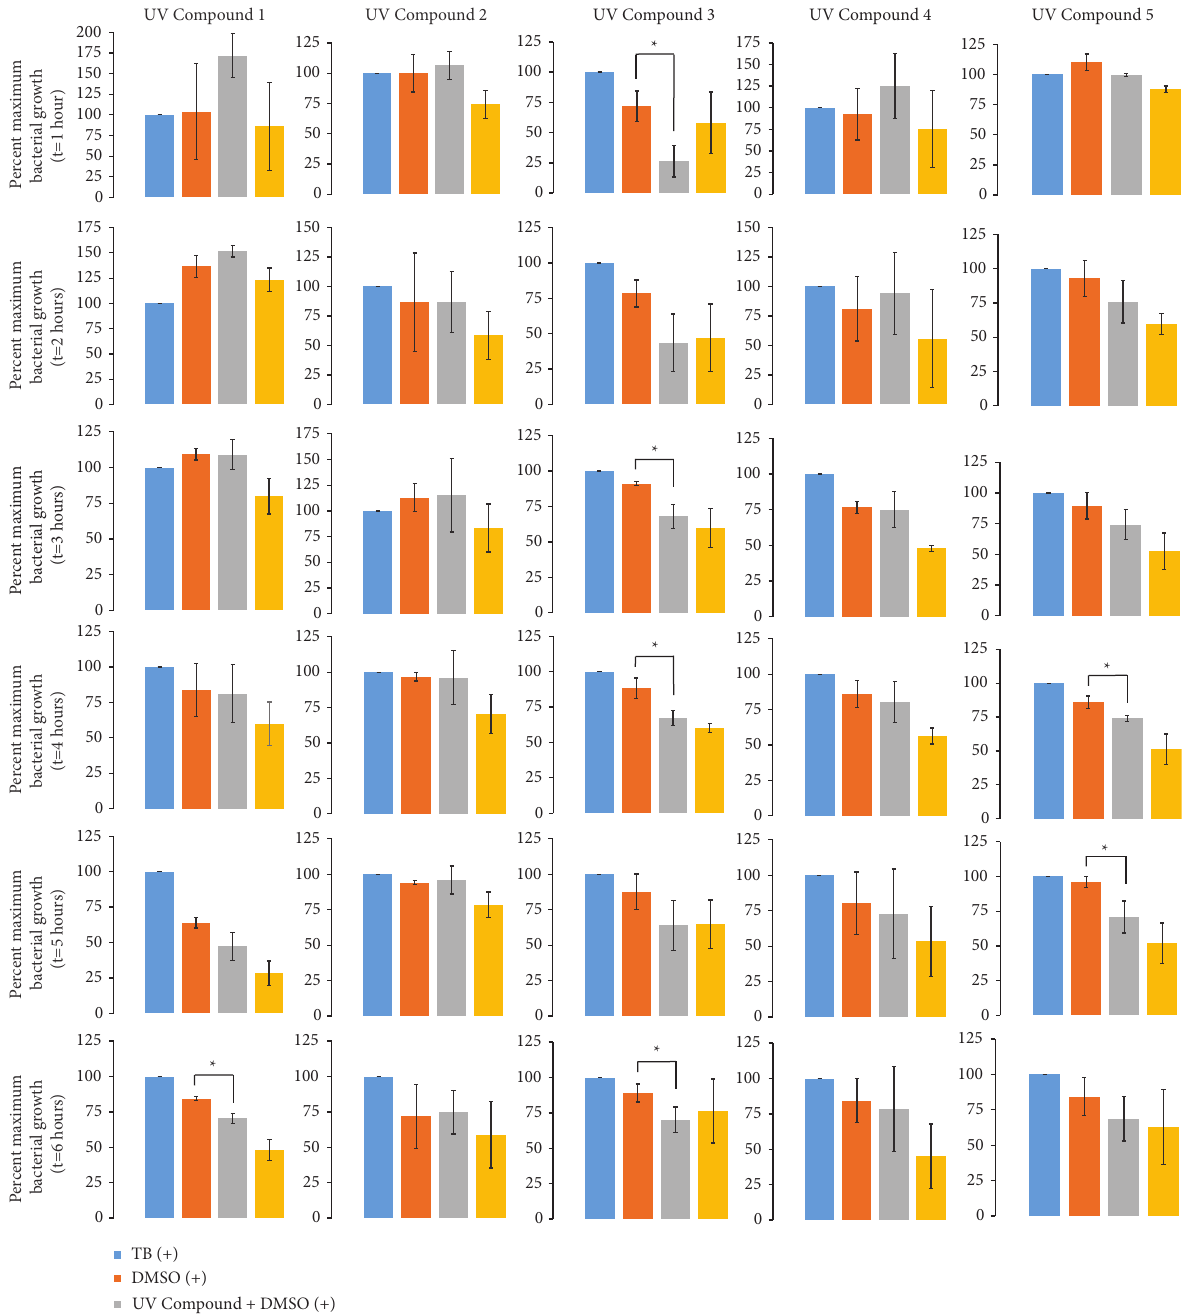
Figure 4: Time-course analysis of bacterial growth. P . aeruginosa growth at 1/16 dilutions over six hours of incubation at 37 ° C at one-hour intervals expressed as percent maximum where growth at 100% is represented by TB+ ( n � 4 for UV compound 1 and n � 3 for UV compounds 2–5). Experimental conditions compared TB combined with P . aeruginosa culture (light blue, TB+), DMSO combined with P . aeruginosa (red, DMSO+), compound dissolved in DMSO combined with P . aeruginosa (gray, UV compound+DMSO+), kanamycin combined with P. aeruginosa (yellow, kanamycin+), and compound combined with DMSO without the presence of P. aeruginosa (dark blue, UV compound+DMSO − ). Significant differences are indicated between DMSO+ and UV compound+DMSO+ with an asterisk ( p < 0 .